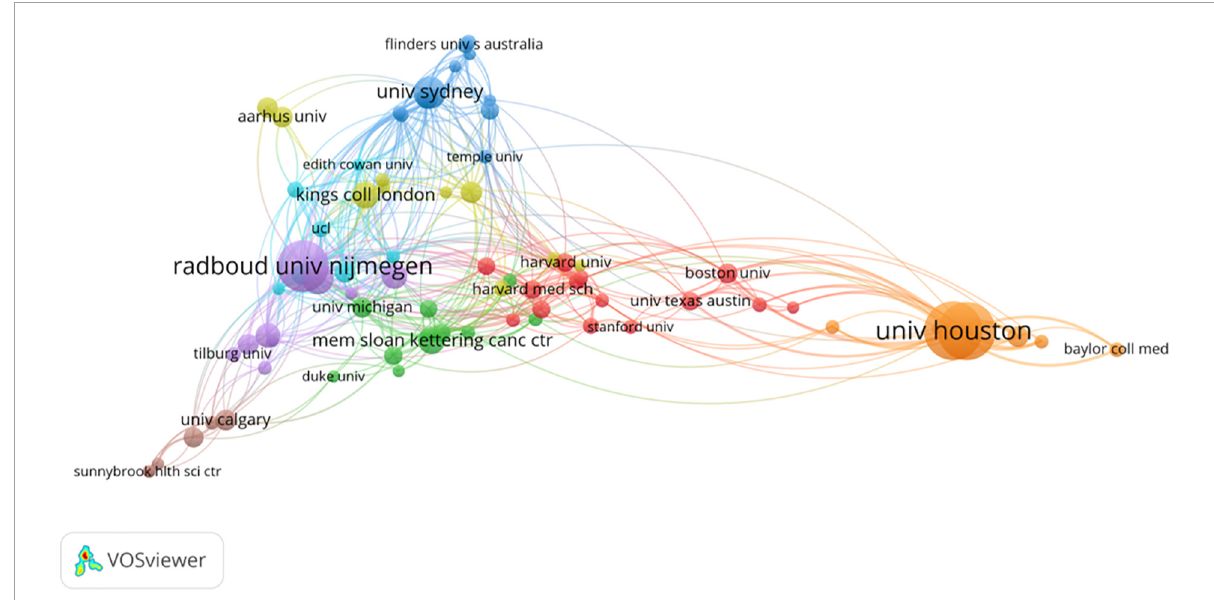
FIGURE5 Co-authorship network diagram between institutions in the area.